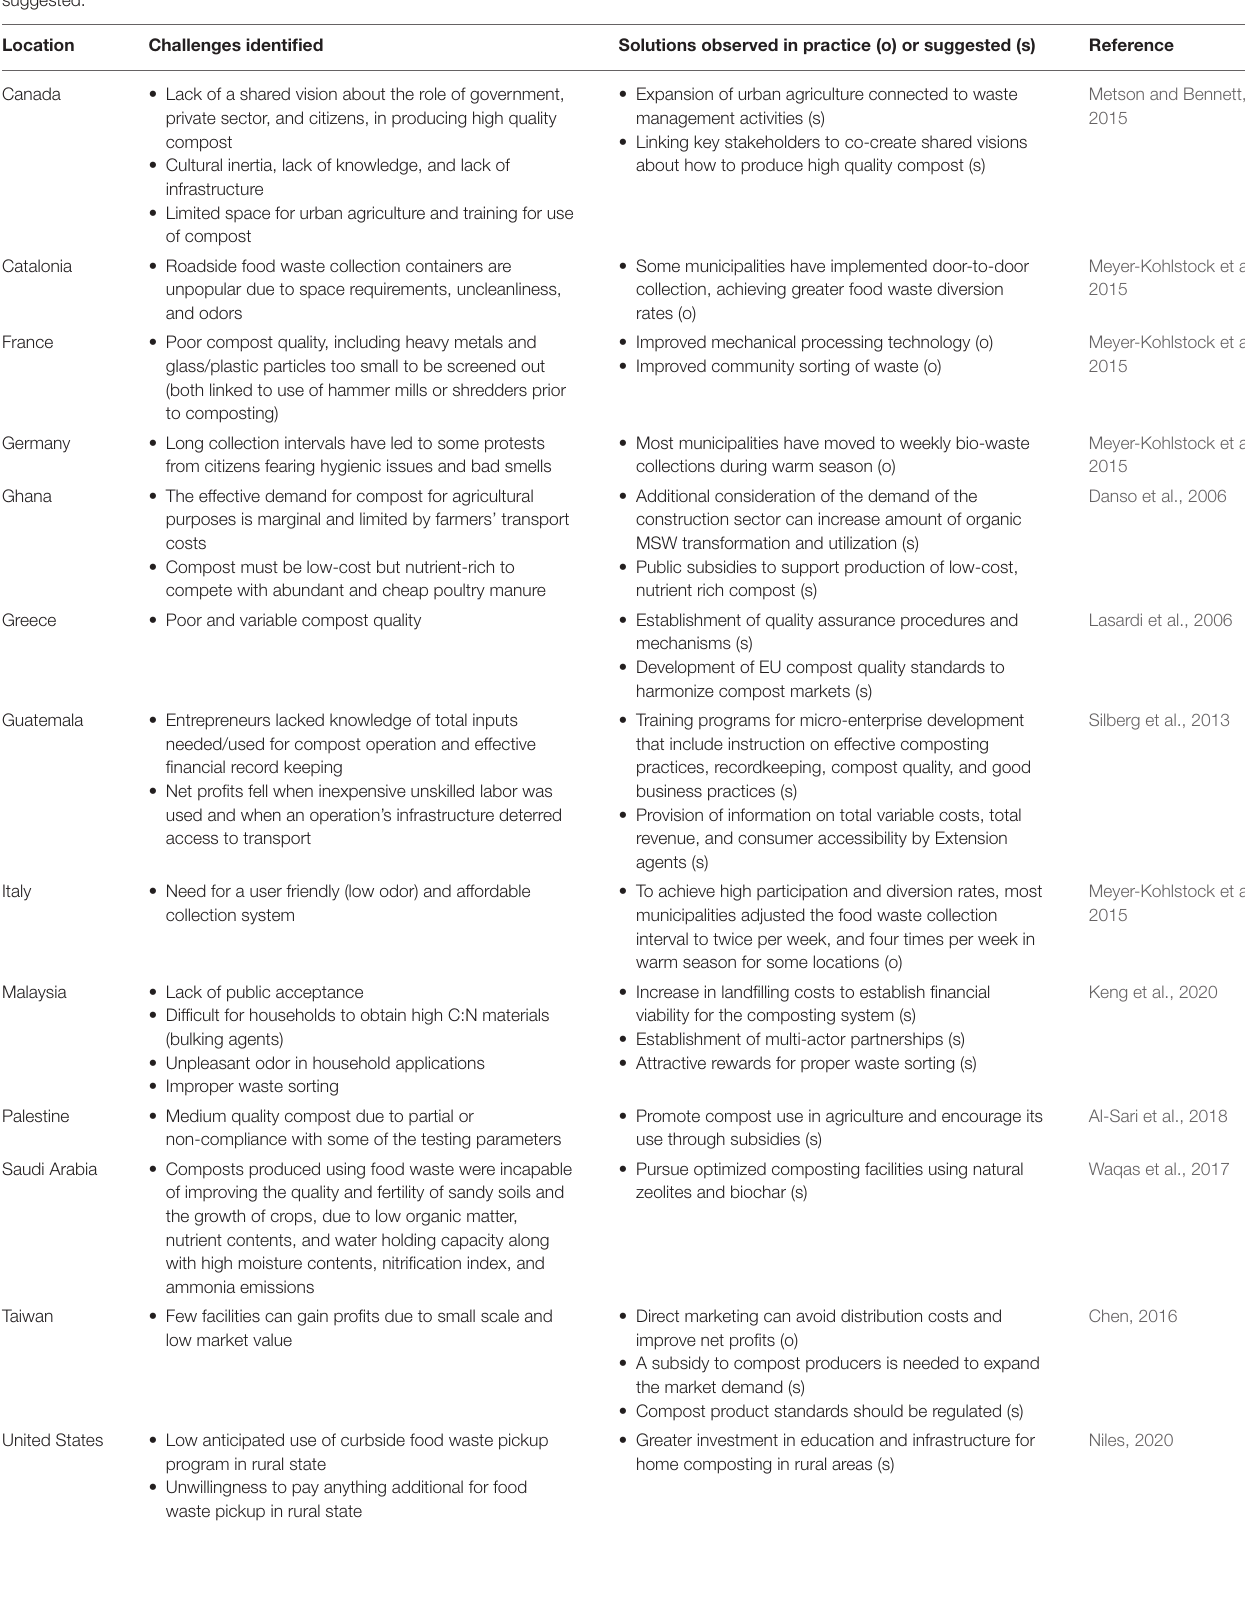
TABLE 1 | Summary of some previous assessments of MSW composting systems around the world, including challenges identified and solutions observed in practice or suggested.